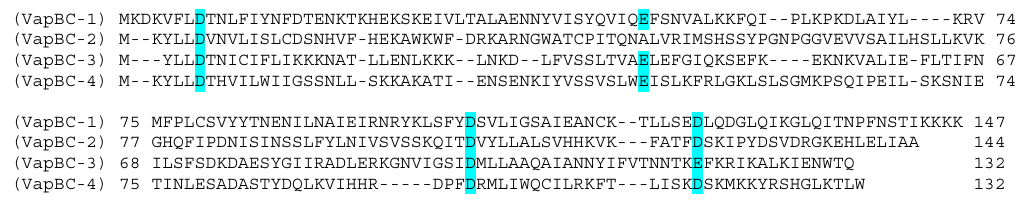
(VapBC-1) MKDKVFLDTNLFIYNFDTENKTKHEKSKEIVLTALAENNYVISYQVIQEFSNVALKKFQI--PLKPKDLAIYL----KRV 74 (VapBC-2) M--KYLLDVNVLISLCDSNHVF-HEKAWKWF-DRKARNGWATCPITQNALVRIMSHSSYPGNPGGVEVVSAILHSLLKVK 76 (VapBC-3) M---YLLDTNICIFLIKKKNAT-LLENLKKK--LNKD--LFVSSLTVAELEFGIQKSEFK----EKNKVALIE-FLTIFN 67 (VapBC-4) M--KYLLDTHVILWIIGSSNLL-SKKAKATI--ENSENKIYVSSVSLWEISLKFRLGKLSLSGMKPSQIPEIL-SKSNIE 74 (VapBC-1) 75 MFPLCSVYYTNENILNAIEIRNRYKLSFYDSVLIGSAIEANCK--TLLSEDLQDGLQIKGLQITNPFNSTIKKKK 147 (VapBC-2) 77 GHQFIPDNISINSSLFYLNIVSVSSKQITDVYLLALSVHHKVK---FATFDSKIPYDSVDRGKEHLELIAA 144 (VapBC-3) 68 ILSFSDKDAESYGIIRADLERKGNVIGSIDMLLAAQAIANNYIFVTNNTKEFKRIKALKIENWTQ